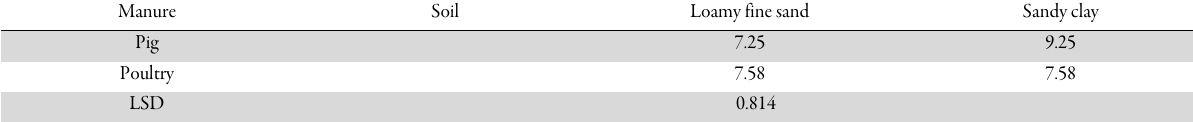
Table 5. Interaction of types of manure and soil texture on number of leaves of tiger nut plants at 7 WAP. Values are a mean of 5 plants